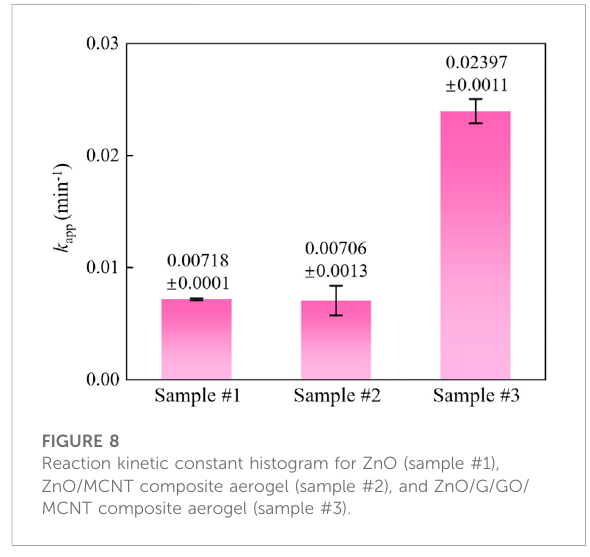
FIGURE 8 Reaction kinetic constant histogram for ZnO (sample #1), ZnO/MCNT composite aerogel (sample #2), and ZnO/G/GO/ MCNT composite aerogel (sample